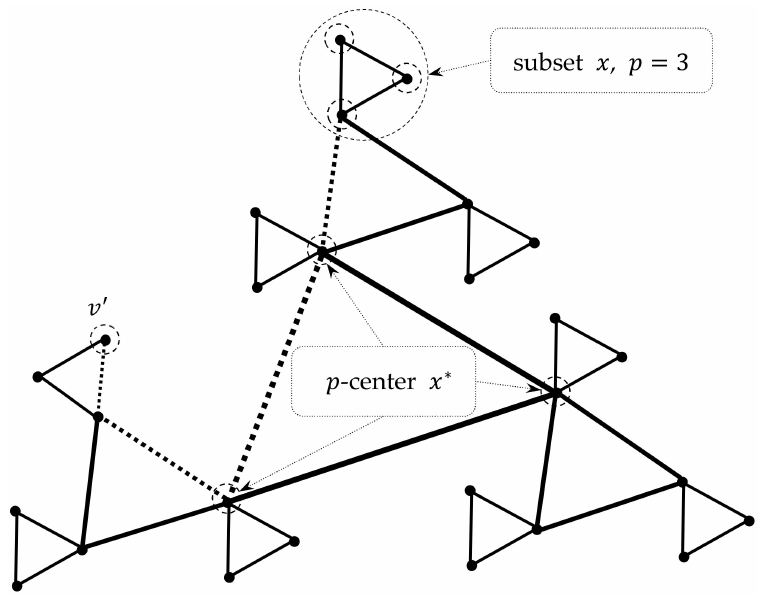
Figure 1. Prefractal graph G 3 generated by a complete 3-vertex seed, the old edges of which are adjacent.